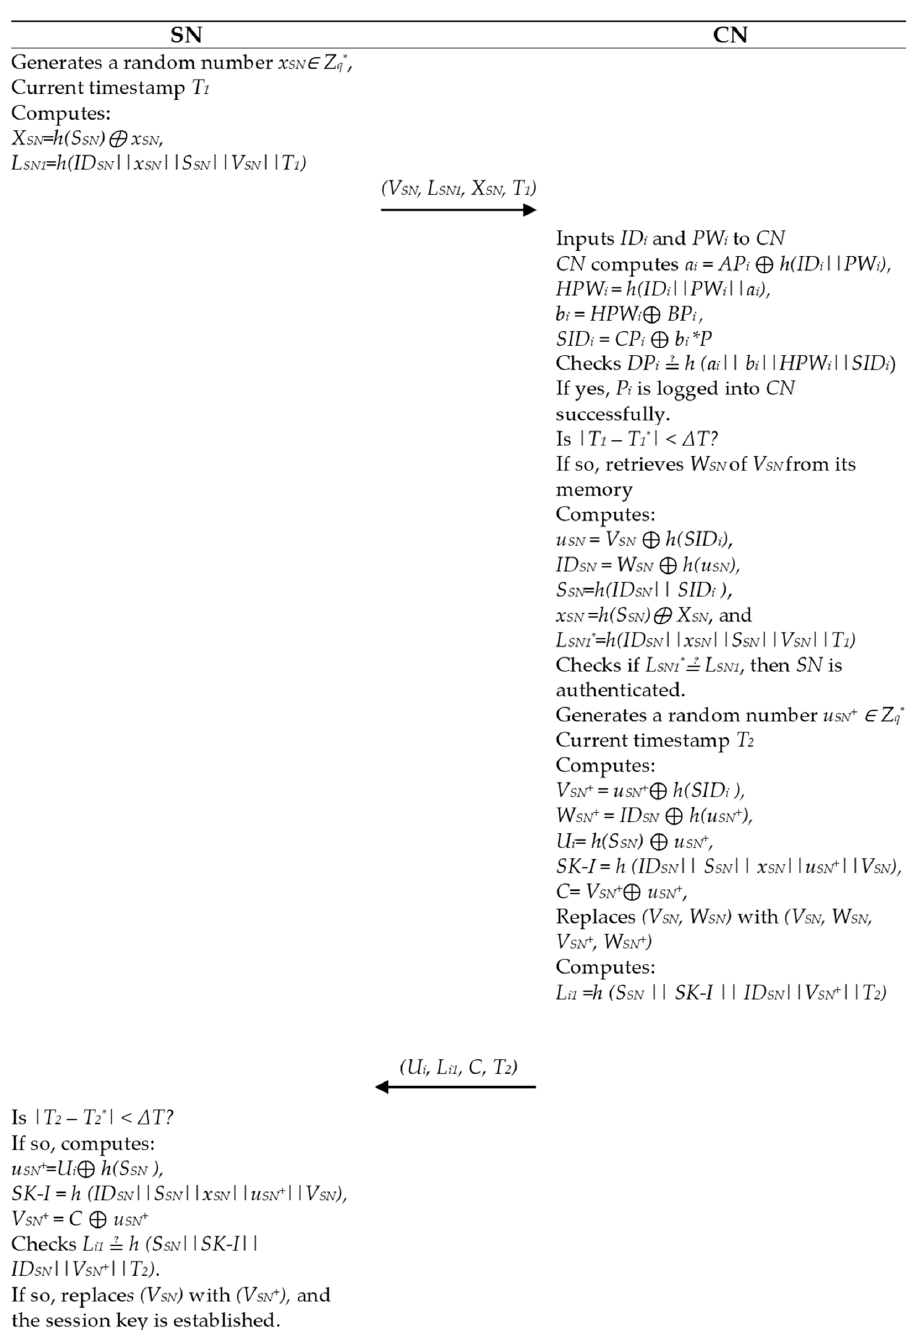
Figure 3. Authentication protocol-I.